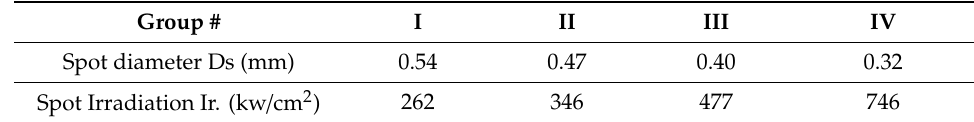
Table 1. Group number corresponding to di ff erent spot irradiation.